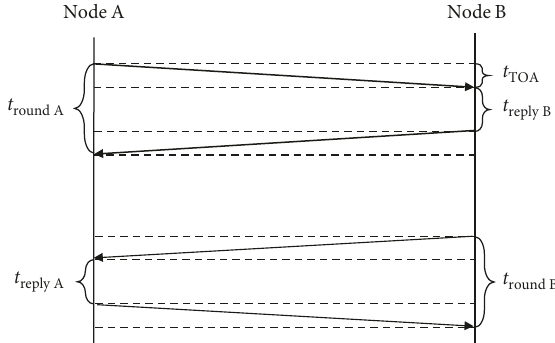
Figure 2: Measuring process of the TOA ranging method.